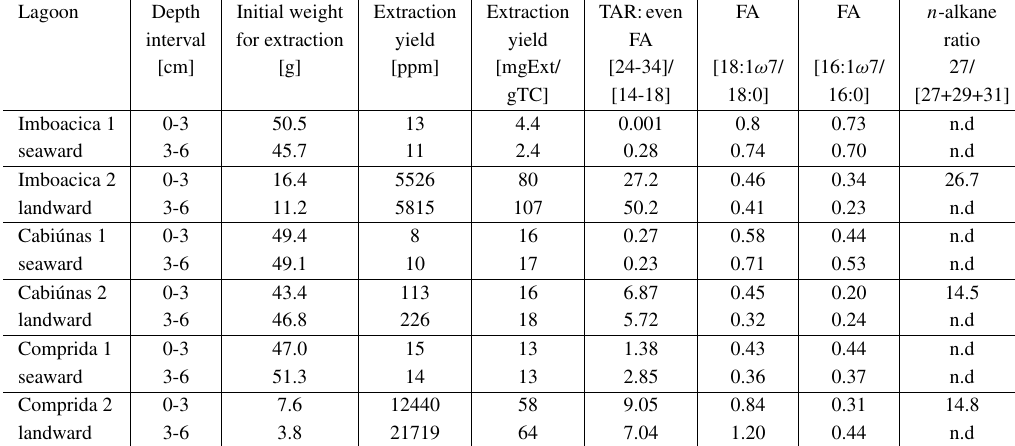
Biomarkers detected in all studied samples (1: seaward site; 2: landward